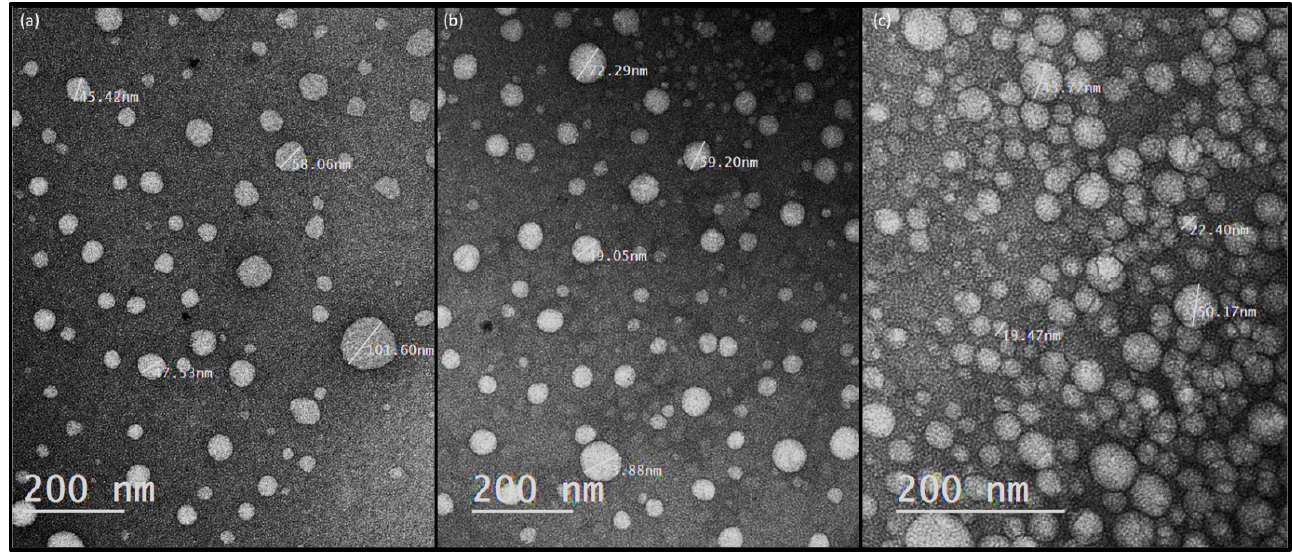
Figure 2. Transmission electron microscope micrographs, showing the droplet size of oil-in-water nanoemulsions prepared from three different oils: ( a ) olive oil-in-water nanoemulsion, ( b ) corn oil-in-water nanoemulsion, and ( c ) linseed oil-in-water nanoemulsion.